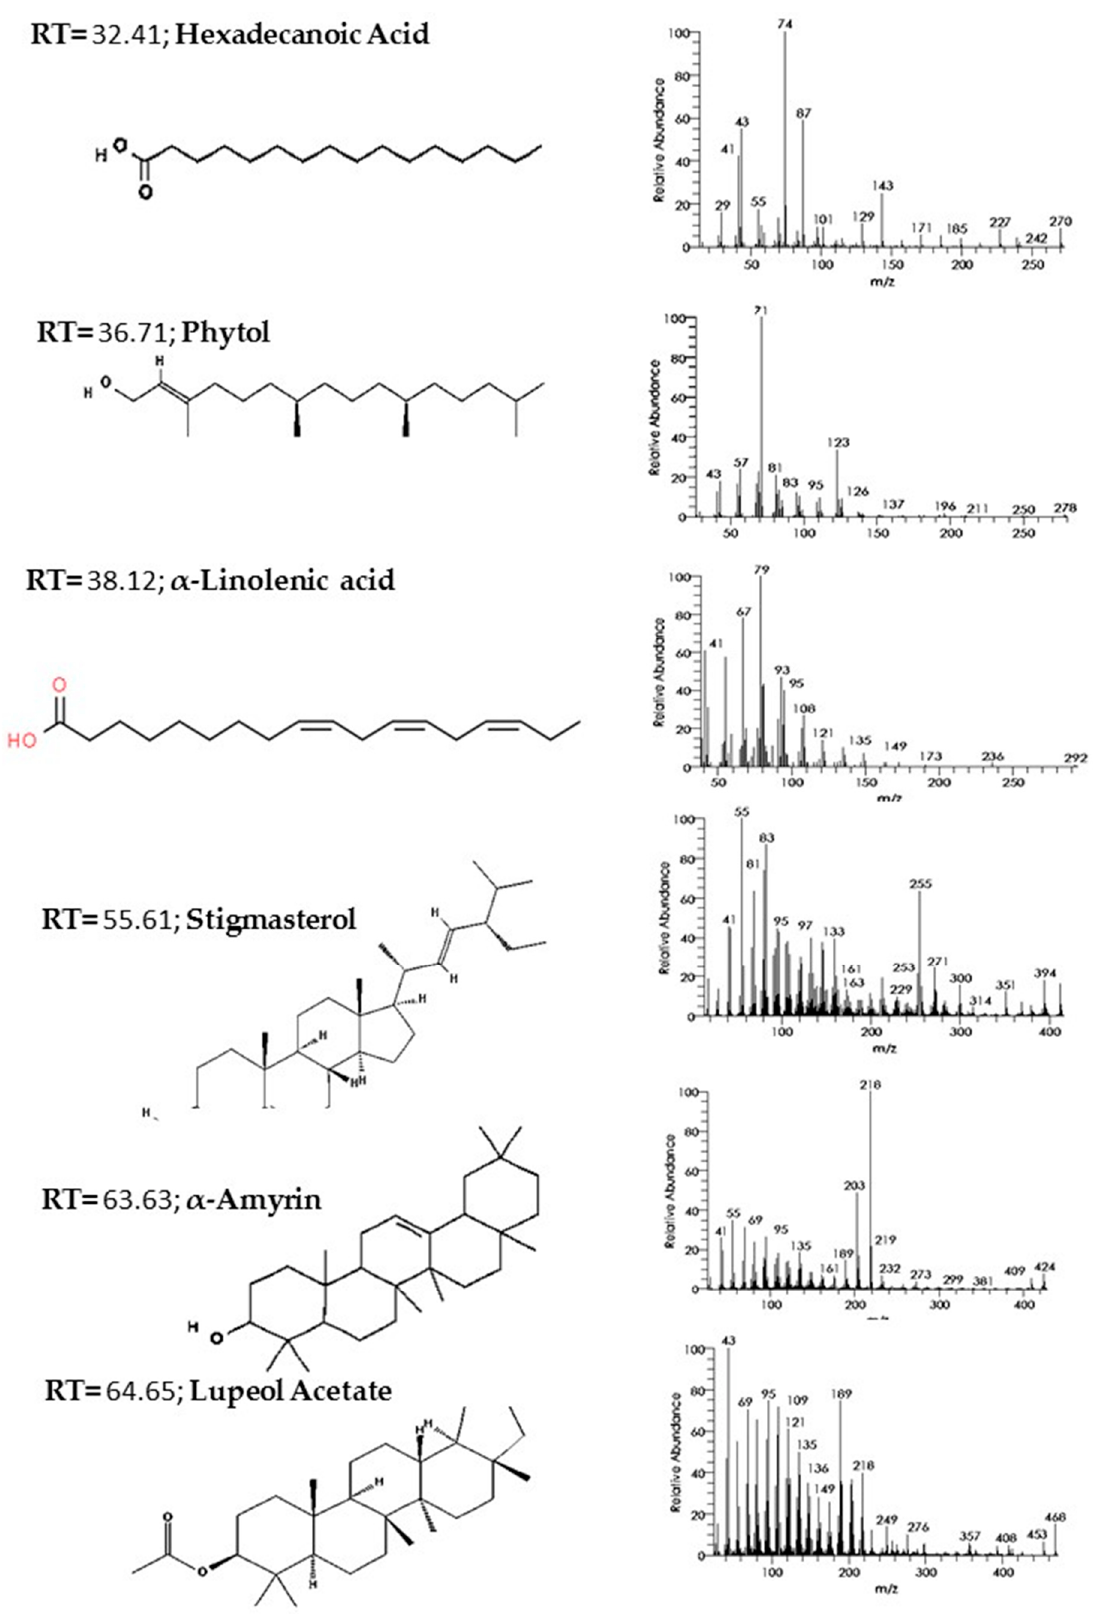
Figure 6. Hit spectra and chemical structures of the major phytochemical constituents of C. procera leaf extract. Chemical structure taken from ChemSpider web site, (accessed on 20 October 2021): hexadecanoic acid, phytol, stigmasterol, linolenic acid, α -amyrin, lupeol acetate.